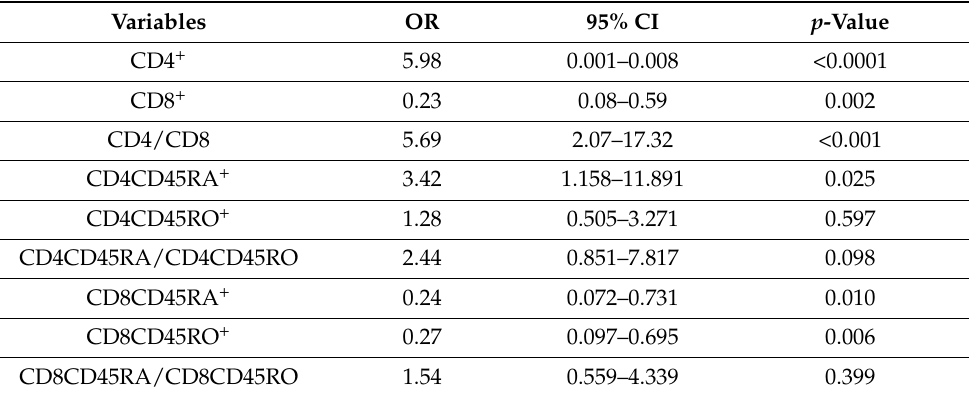
Table 9. The odds ratios for the distribution of T lymphocytes. The parameter ranges given in the rows of the contingency tables were determined based on the cut-off values calculated on the ROC